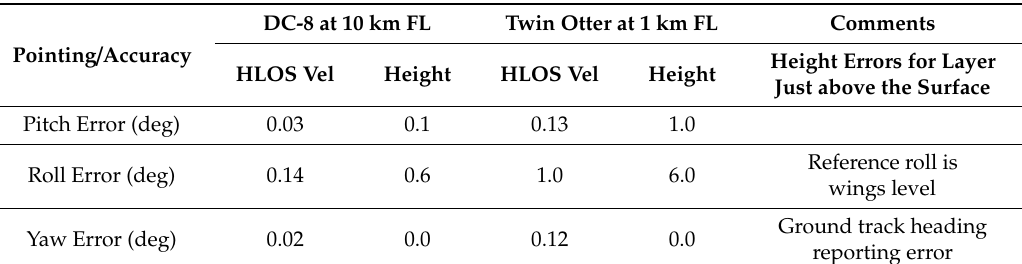
Table 4. Attitude accuracy thresholds to achieve Horizontal LOS (HLOS) velocity accuracy of 0.1 m / s and height assignment < 10 m with a 30 ◦ nadir scan angle. DC-8 at 250 m / s ground speed; Twin Otter at 50 m / s ground